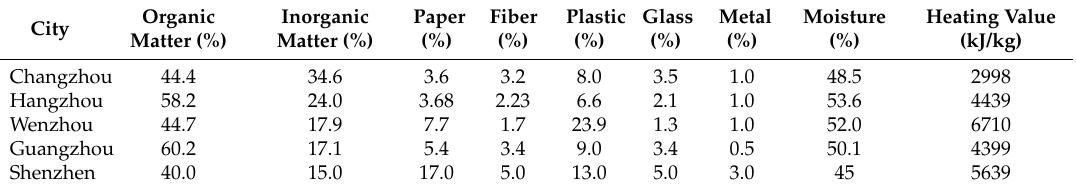
Table 3. The composition of MSW in some of Chinas’ cities